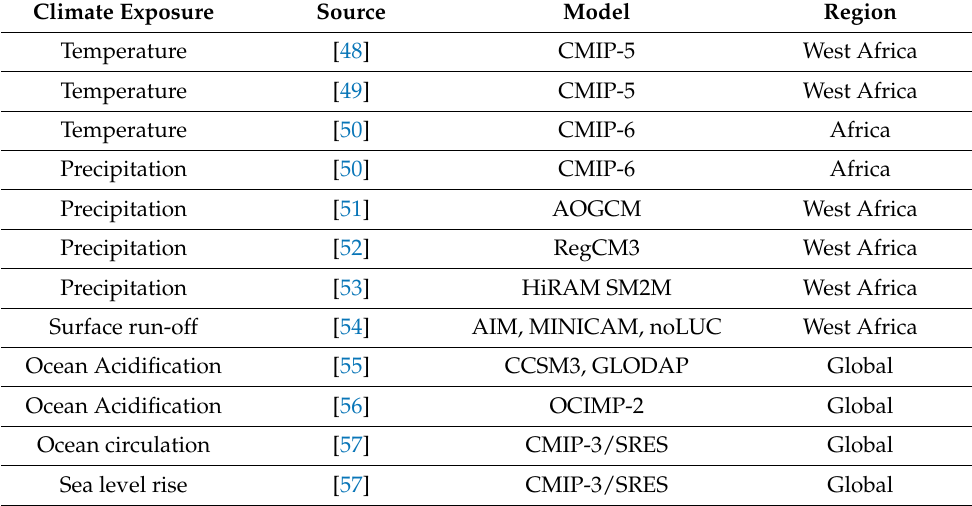
Table 3. Inferred climate exposure resources used for the vulnerability